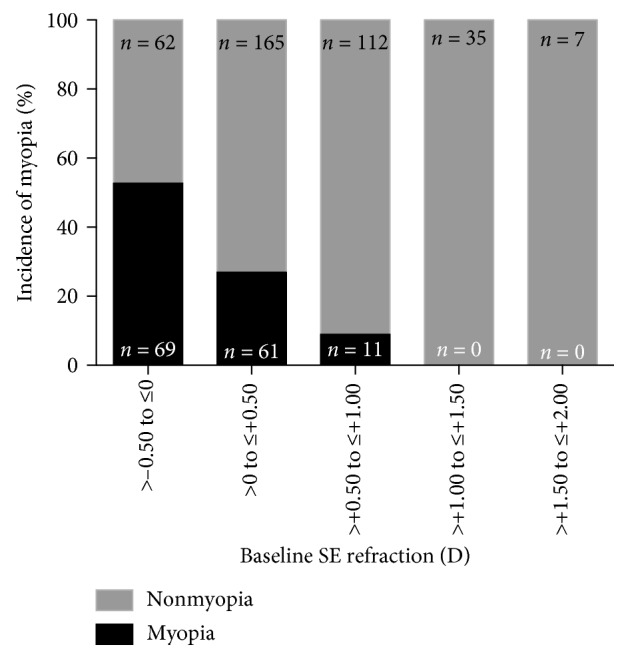
Proportion of children with and without incident myopia according to the baseline spherical equivalent refraction.